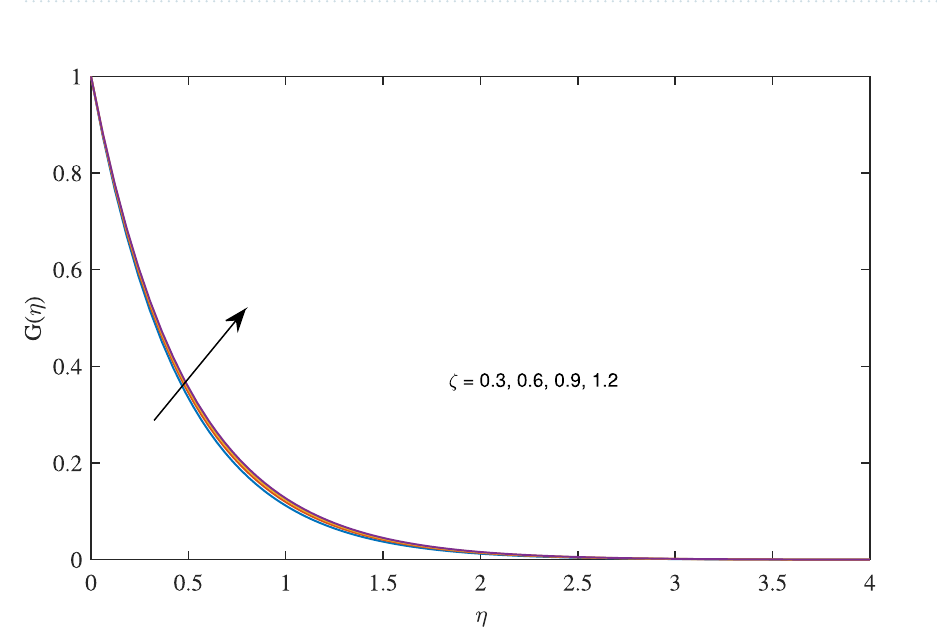
Figure 16. Effects of critical shear rate β on azimuthal velocity, when c 0.1 and Pr φ =